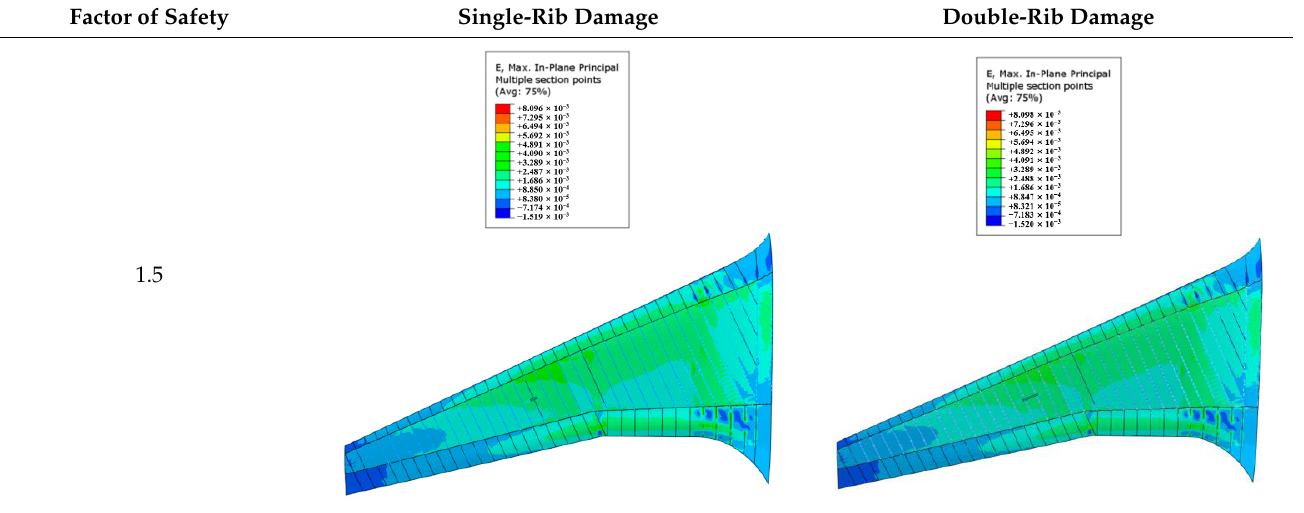
Figure 11. Location of stress concentration in the lower skin component at F.o.S. = 2 (single-rib damage on the left, double-rib damage on the right). Table 16. Results of the maximum in-plane principal strain of single-rib and double-rib damage BWB wings at different values of F.o.S.